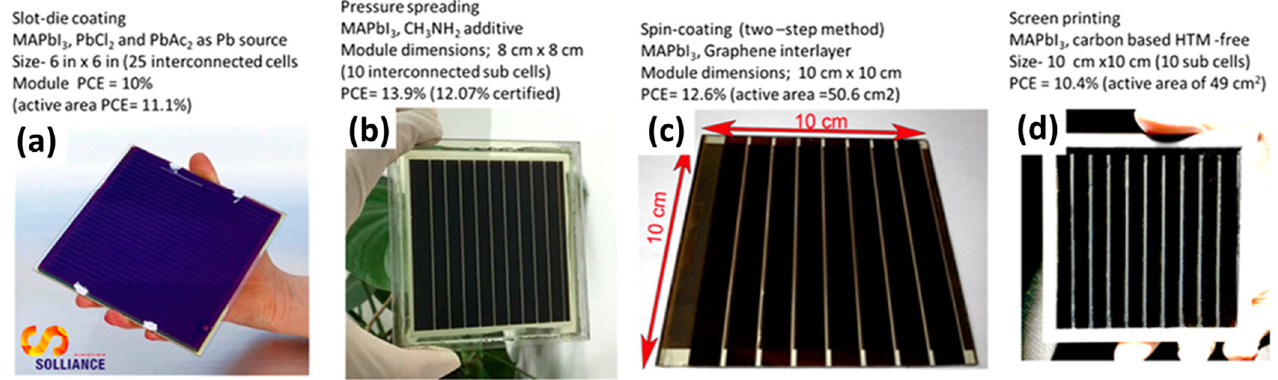
Figure 10. Photographs of some large-area perovskite solar modules [117].